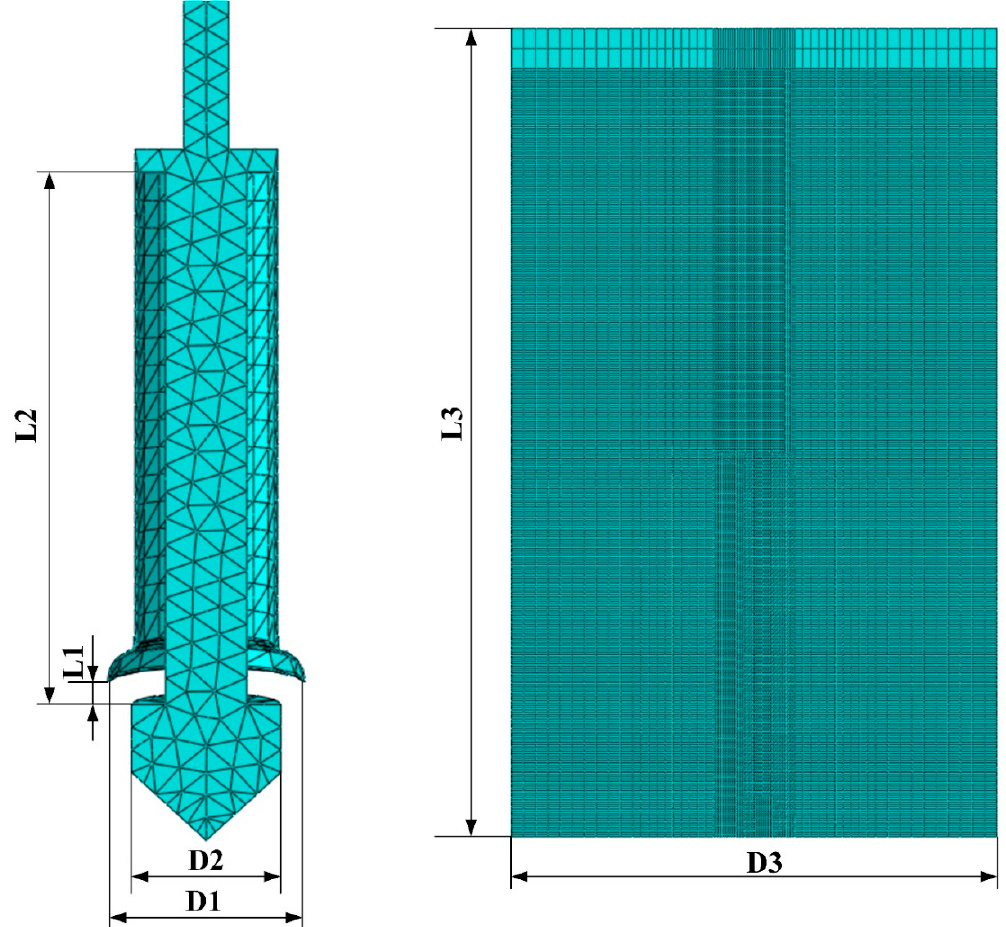
Figure 4. Simulation analysis model diagram.